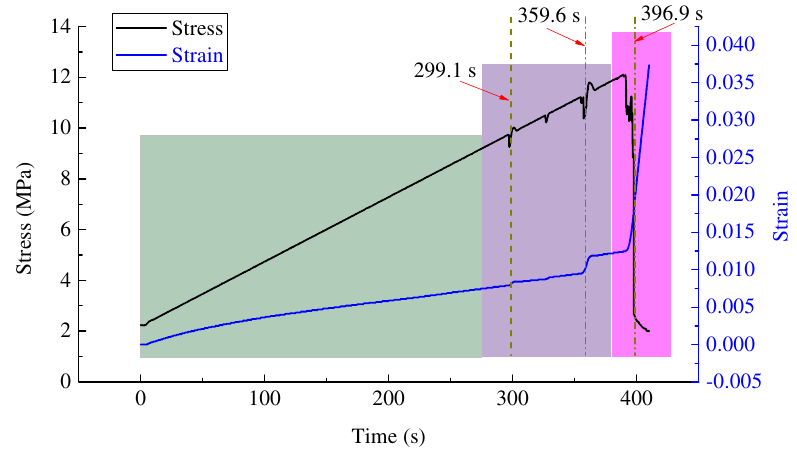
Figure 10. Experimental results of stress and strain during loading process of gas-bearing coal.